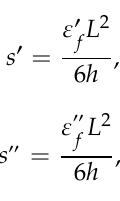
Figure 22. Weight loss variation over time for MUF-ENB after thermal exposure at 60, 80, and 120 °C.